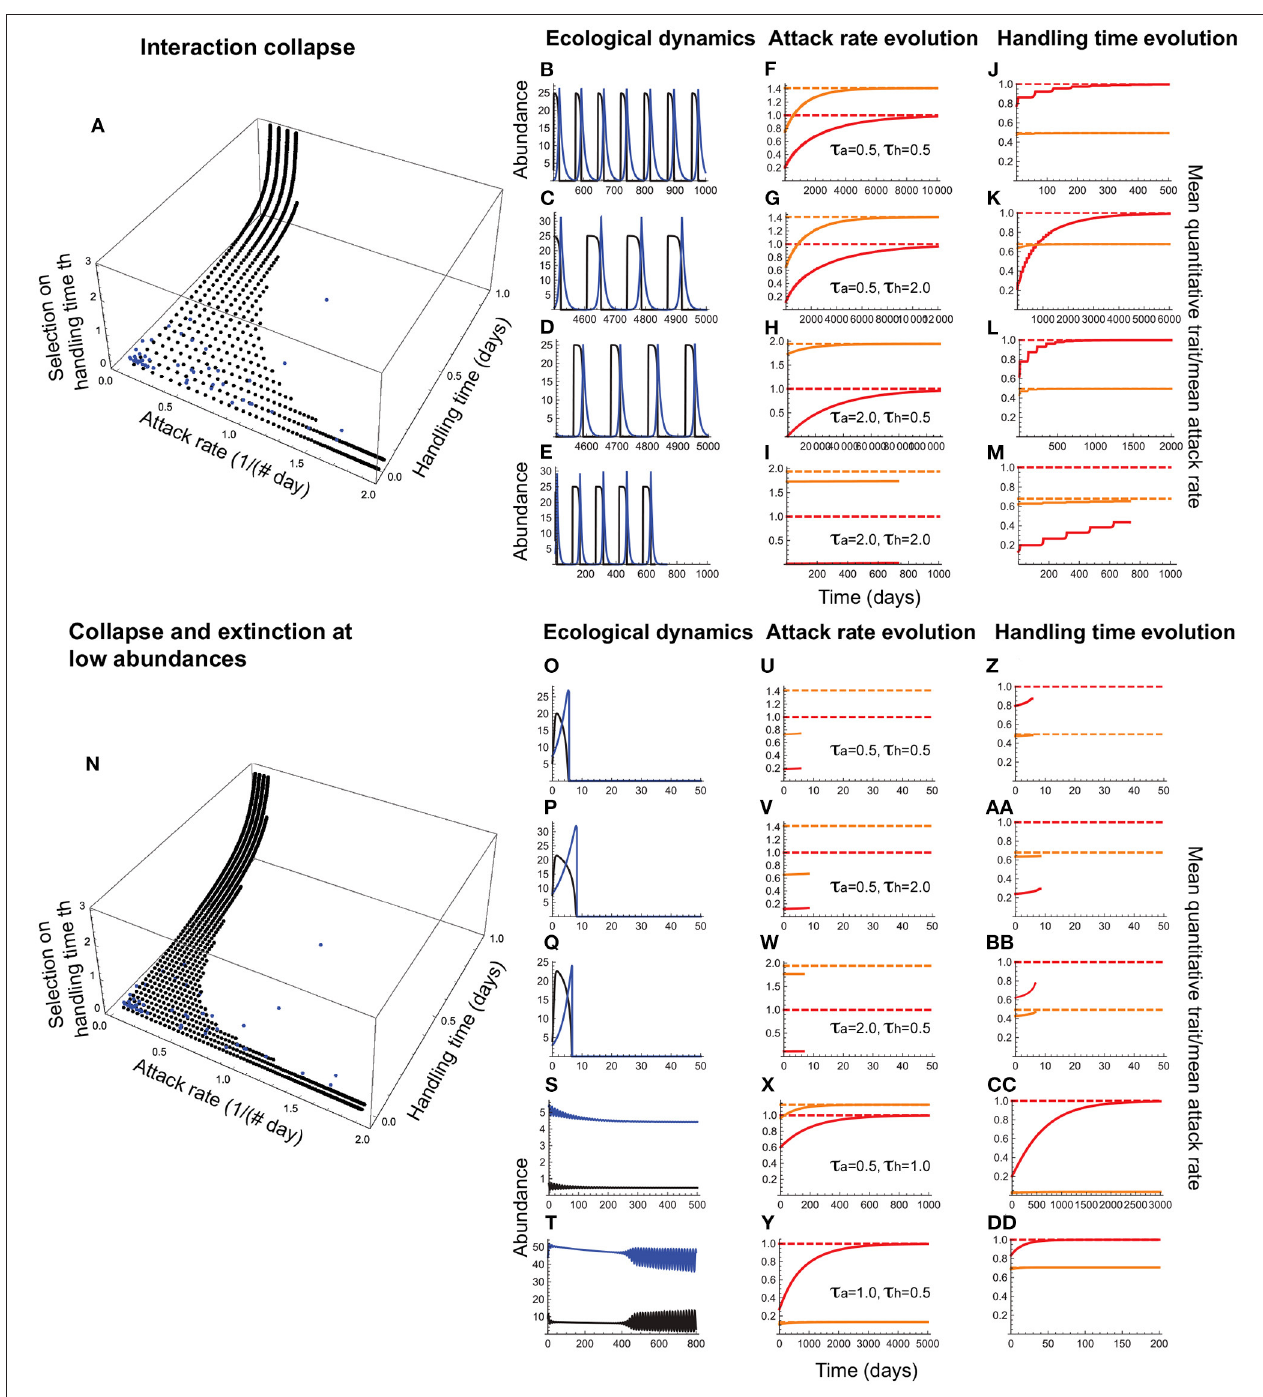
FIGURE 7 | Joint evolution of the attack rate and handling time when the former is a consumer trait and the latter is a resource trait. (A–M) depict outcomes under collapse, and (N–DD) , collapse combined with extinction at low abundances. In (A,N) , the black circles depict the attack rate-handling combinations that evolve in the model as a function of stabilizing selection strength on the handling time ( τ h ; note that the lower the τ h , the stronger is the selection); the curves consisting of evenly spaced circles parallel to the handling time axis depict the evolved outcomes under a given selection strength on the attack rate ( τ a ). The blue circles depict the empirically observed attack rate-handling time combinations. (B–E,O–T) depict resource (black) and consumer (blue) abundances, (F–I,U–Y) depict the mean attack rate [ a ( x ), orange curve] and its expected optimum [ optimum θ a , dashed red line. (J–M,Z–DD) depict the mean handling time [ h ( y ), orange curve], its expected optimum [